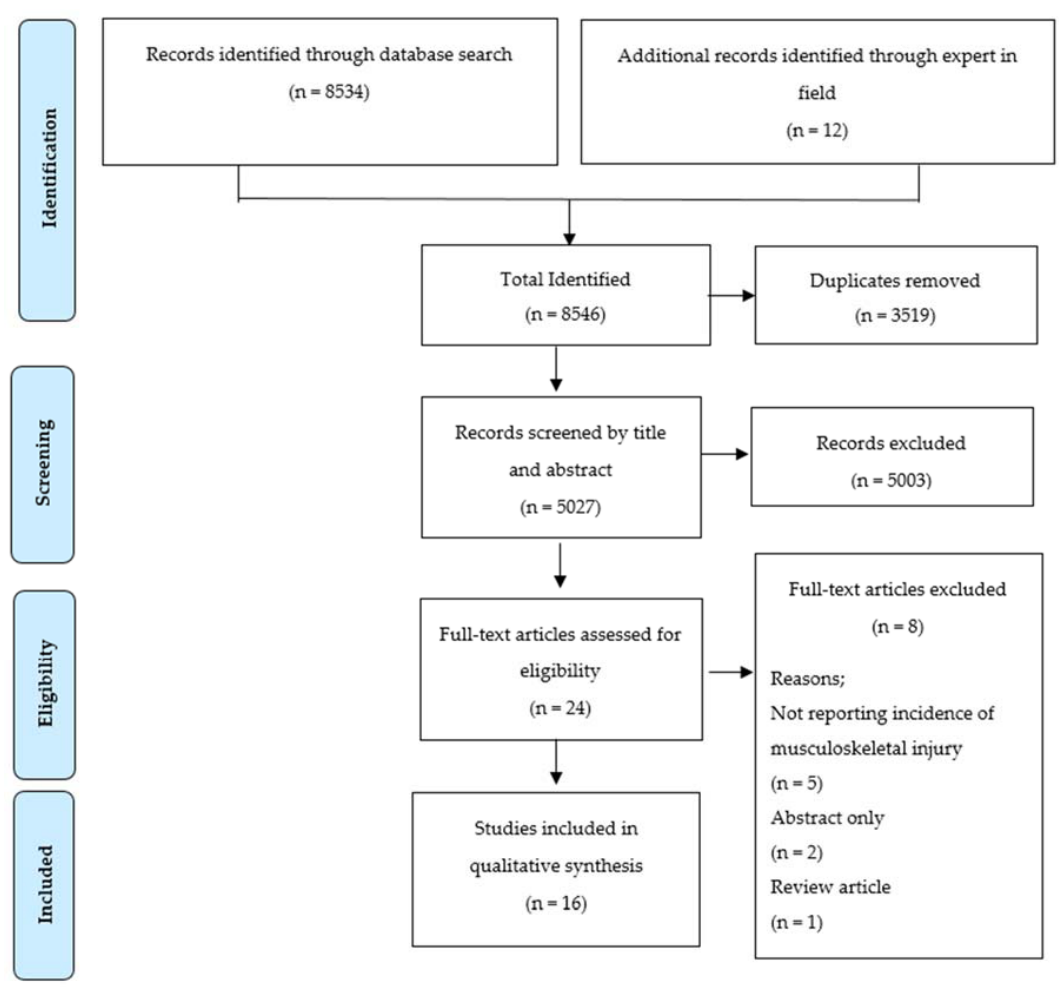
Figure 1. PRISMA flow diagram showing literature search, screening and eligibility results.